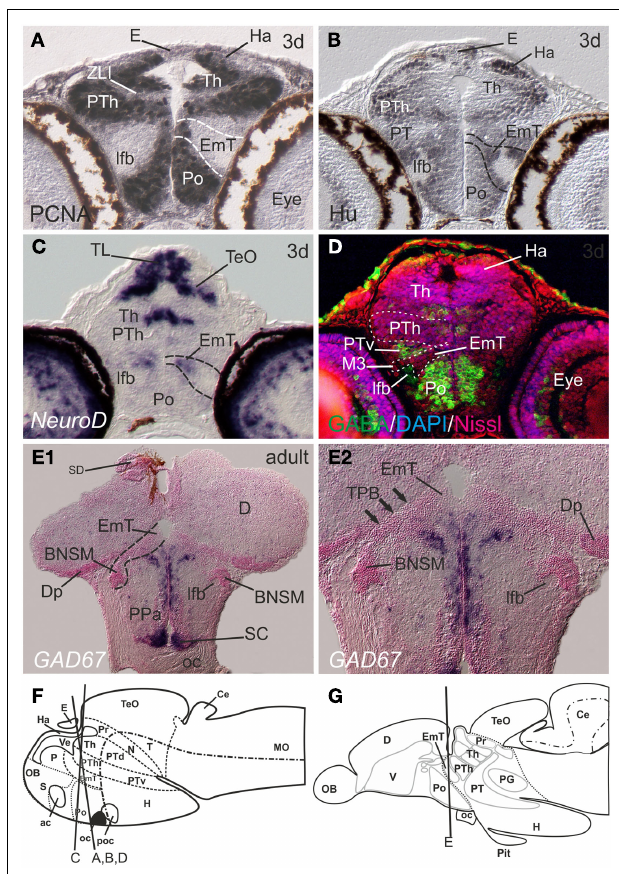
FIGURE 5 |The location of the eminentia thalami (EmT) in postembryonic and adult zebrafish. (A–E) In larval zebrafish, the periventricular proliferative zone [PCNA-positive in (A) and Hu-negative in (B) ] of the EmT is located between ventral thalamus (VT) and preoptic region (Po). (C) Postmitotic EmT-cells expressing neuroD -mRNA migrate toward the lateral forebrain bundle (lfb). (D) Both, proliferative and postmitotic cells of the EmT in the larval brain are free of GABA cells, whereas surrounding regions, such as the ventral posterior tuberculum (PTv) and preoptic region (Po) show many GABA cells. Note, the ventral thalamus is usually defined by a heavy presence of GABA-expressing cells: here, the ventral thalamus appears GABA-negative, because its proliferative zone is displayed only. (E1 + E2) The EmT in the brain of adult zebrafish is located ventrally adjacent to the posterior zone (Dp) of the pallium, ventrally to the thalamo-pallial border.The derivative of the EmT, the peripheral bed nucleus of the stria medullaris (BNSM, former ventral nucleus of the entopeduncular complex) surrounds the lateral forebrain bundle. Schematic drawings of larval (F) and adult (G) zebrafish brain that indicates the approximate position of transverse sections. Abbreviations see